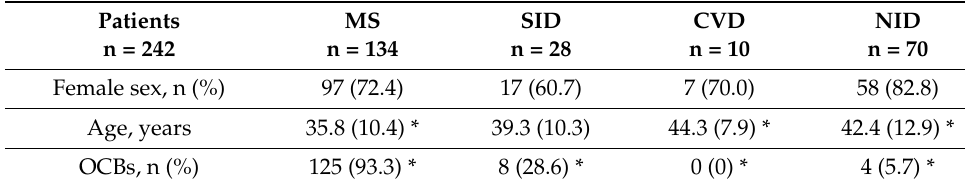
Table 1. Patient demographics.